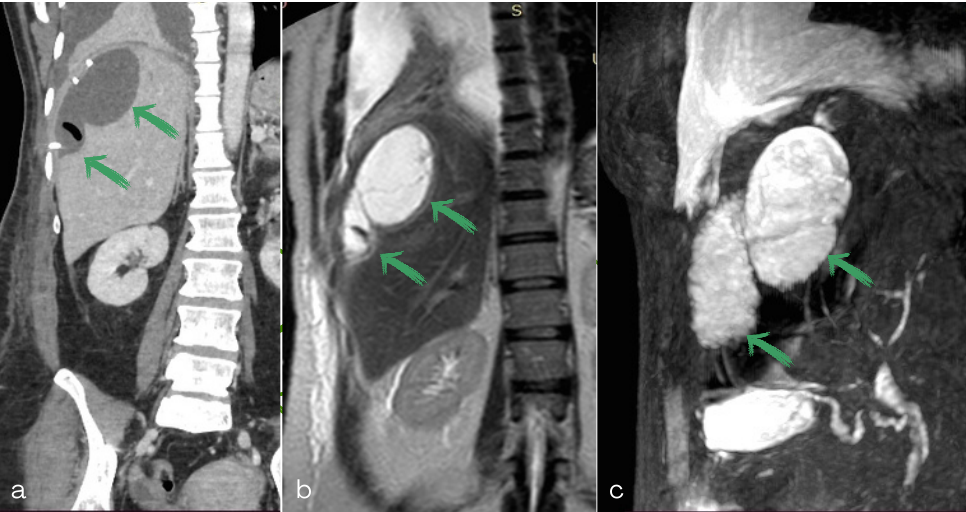
Figure 4. ( a ) Abdominal computed tomography scan, ( b ) magnetic resonance image/T2-weighted image of the abdomen and ( c ) magnetic resonance cholangiopancreatography of the abdomen revealing two separate